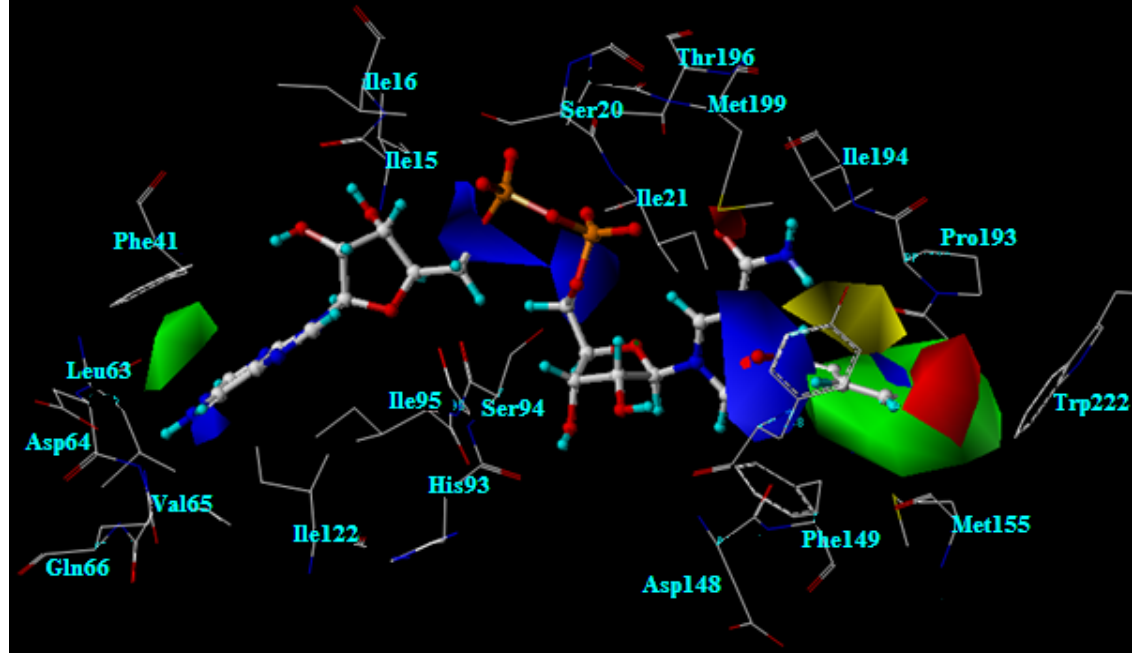
Figure 7. The best CoMSIA contour maps for steric and electrostatic